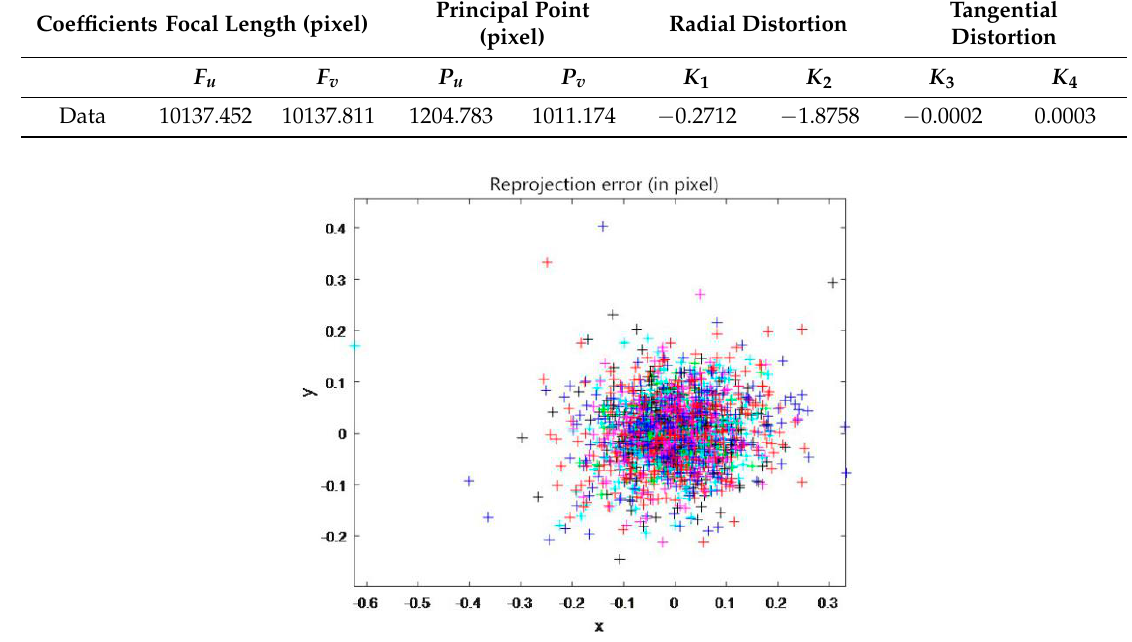
Figure 9. Reprojection error of the calibrated camera.